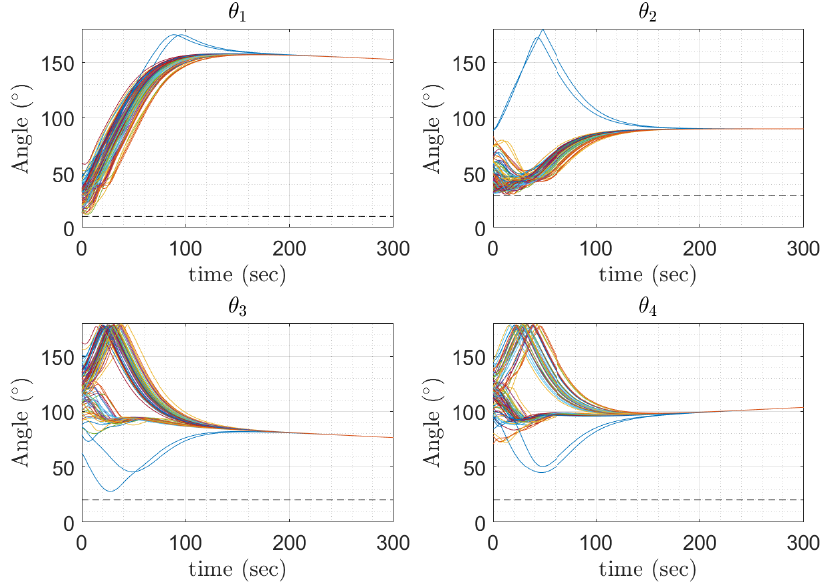
Figure 18. Boresight 1 trajectories with respect to the four exclusion constraints with the inclusion constraint condition